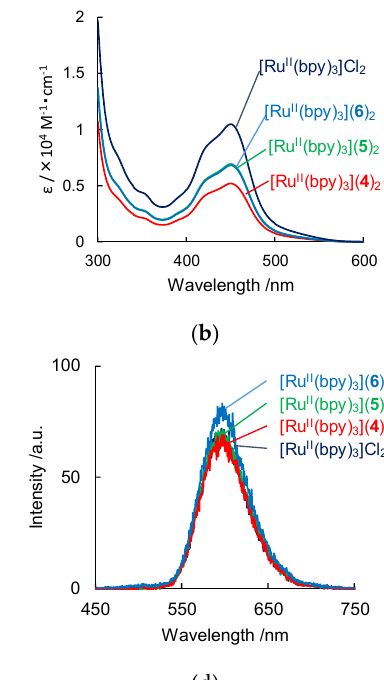
Figure 2. UV-vis absorption spectra ( a , b ) and luminescence spectra ( c , d ) of [Ru II (bpy) 3 ](lipid) 2 (Lipid = 1 – 6 ) in EtOH at 293 K. [Ru II (bpy) 3 ](lipid) 2 = 0.1 mM. Path length: 1 cm. Excitation wavelength = 440 nm.